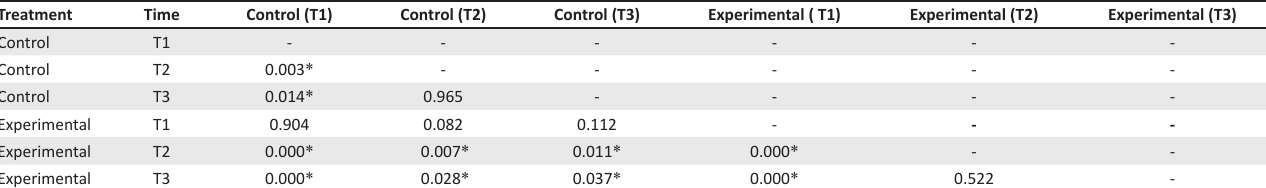
TABLE 2: Least Significance Difference test (post-hoc) results for total EI (Effect: Group * time). Treatment Time